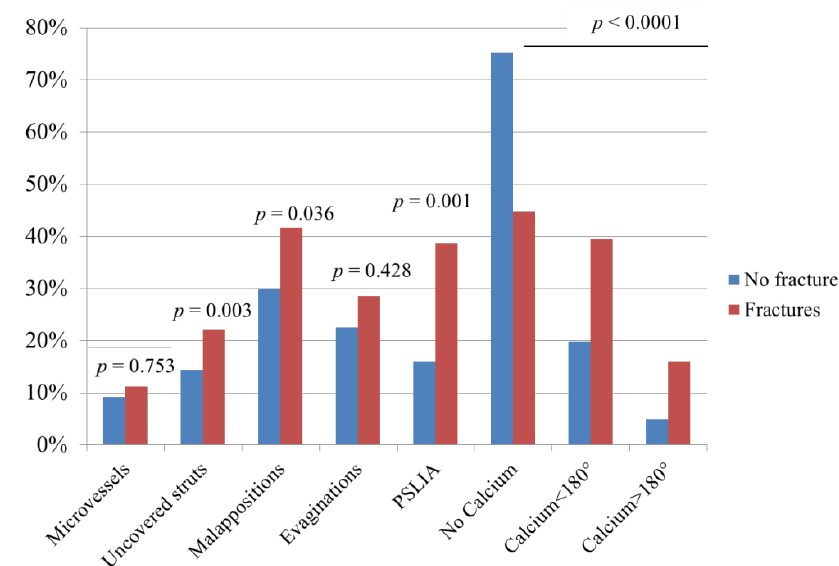
Figure 4. Prevalence of pathological findings in the presence of SF.